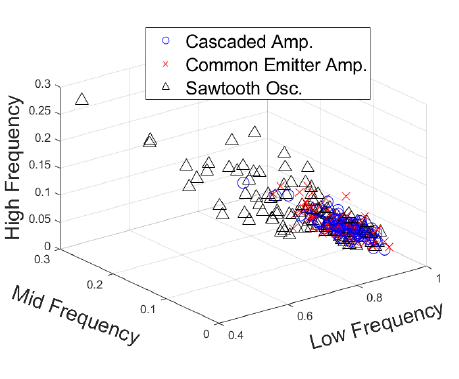
Figure 15. Fourier feature space representation of second and third harmonics data, SNR=2 dB.